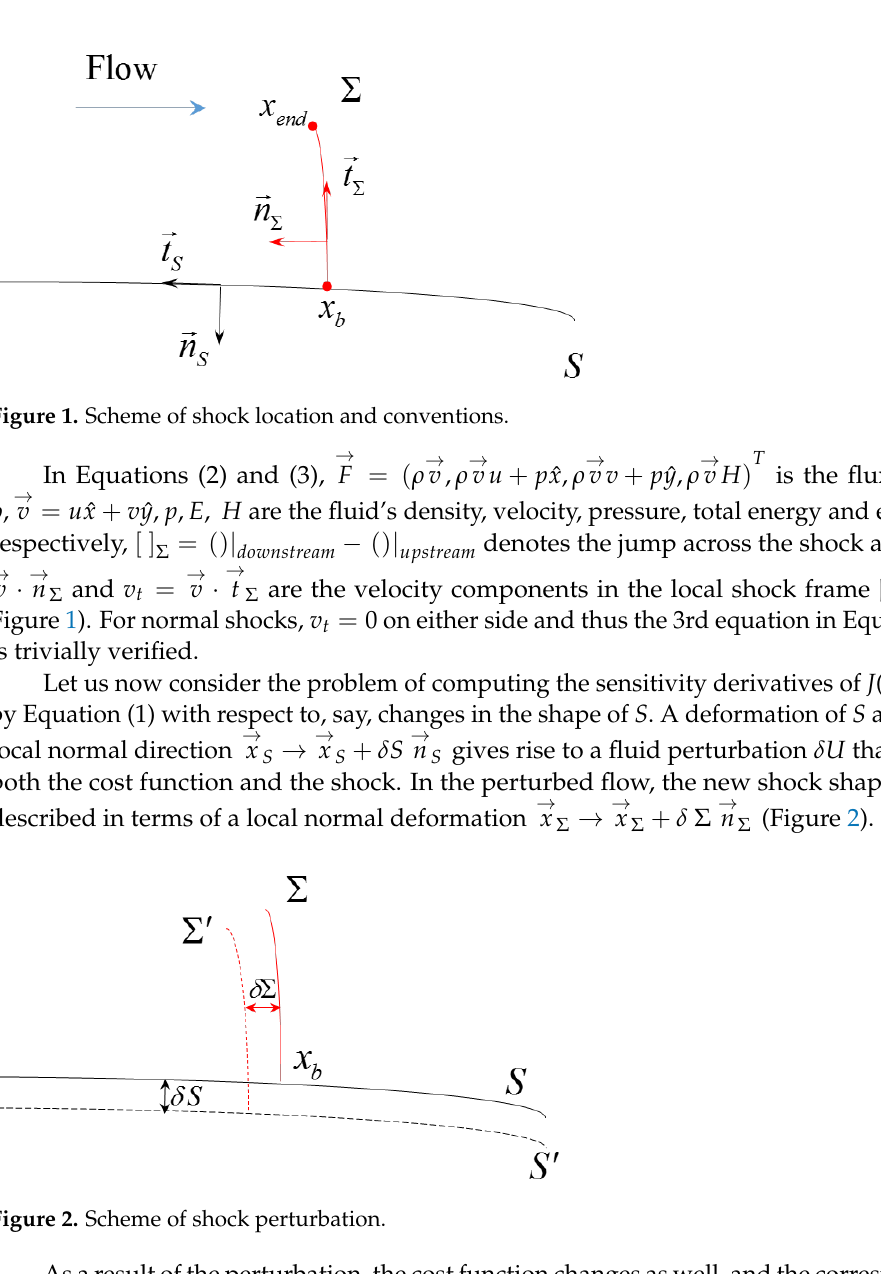
Figure 2. Scheme of shock perturbation.